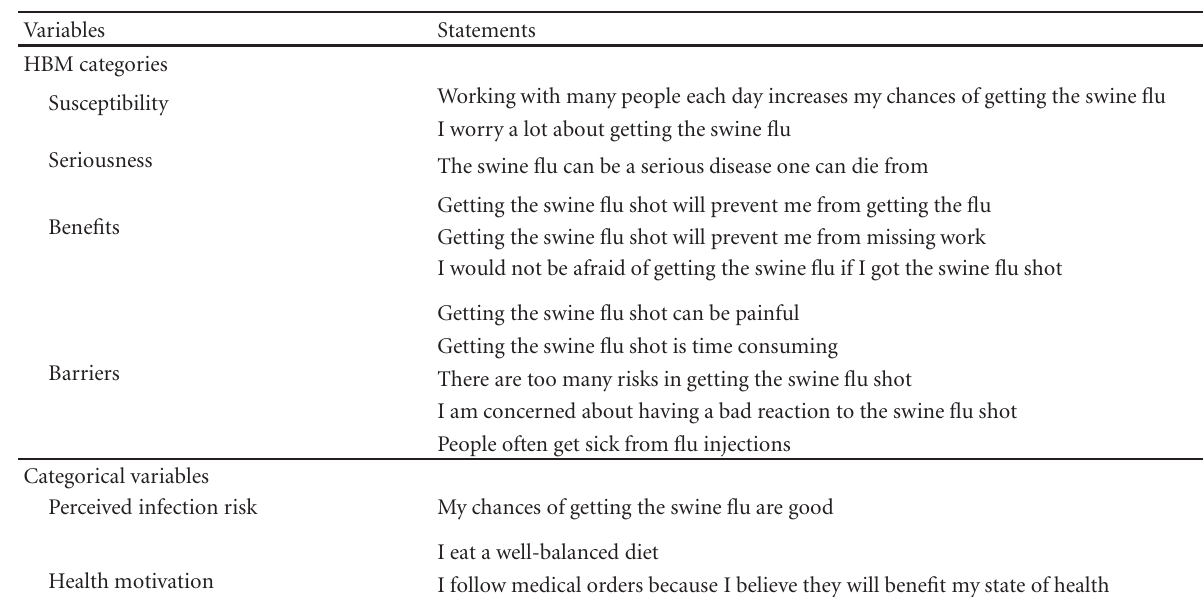
Table 8: HBM categories and categorical variables.